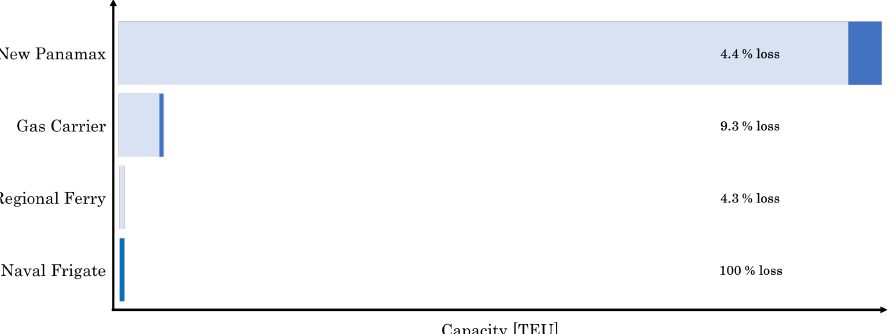
Figure 14. The cargo carrying capacity of the vessels considered in this study and the associated absolute and relative loss of cargo carrying capacity compared to conventional vessels.